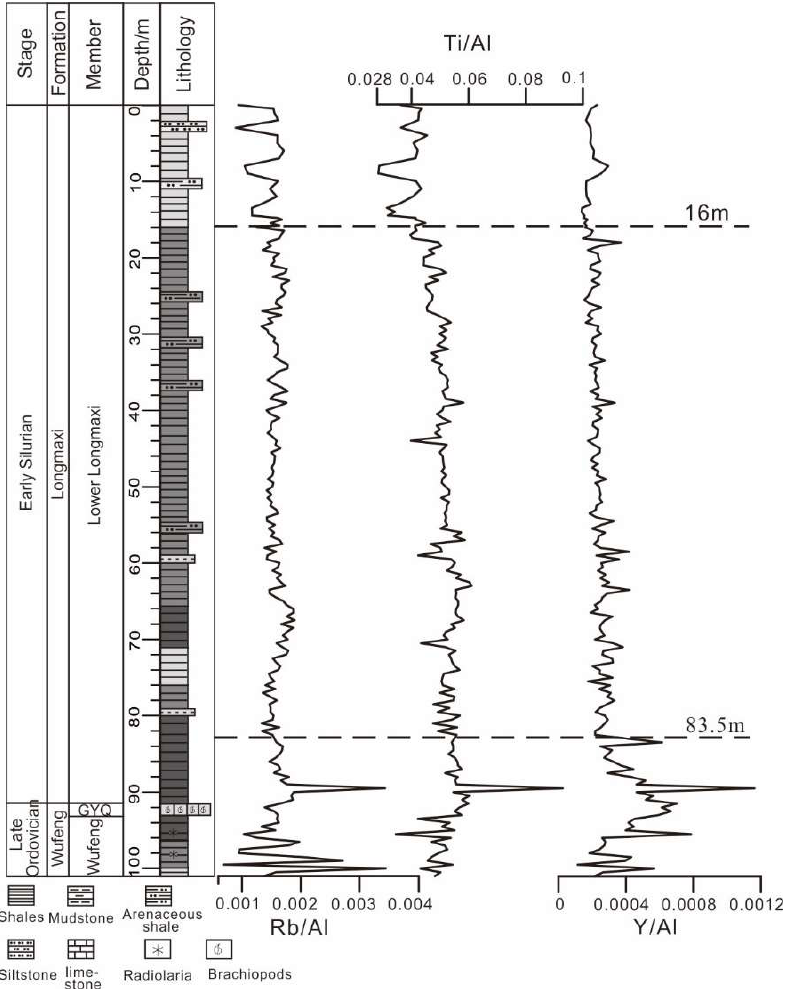
Figure 7. The Rb/Al, Ti/Al, and Y/Al profiles.